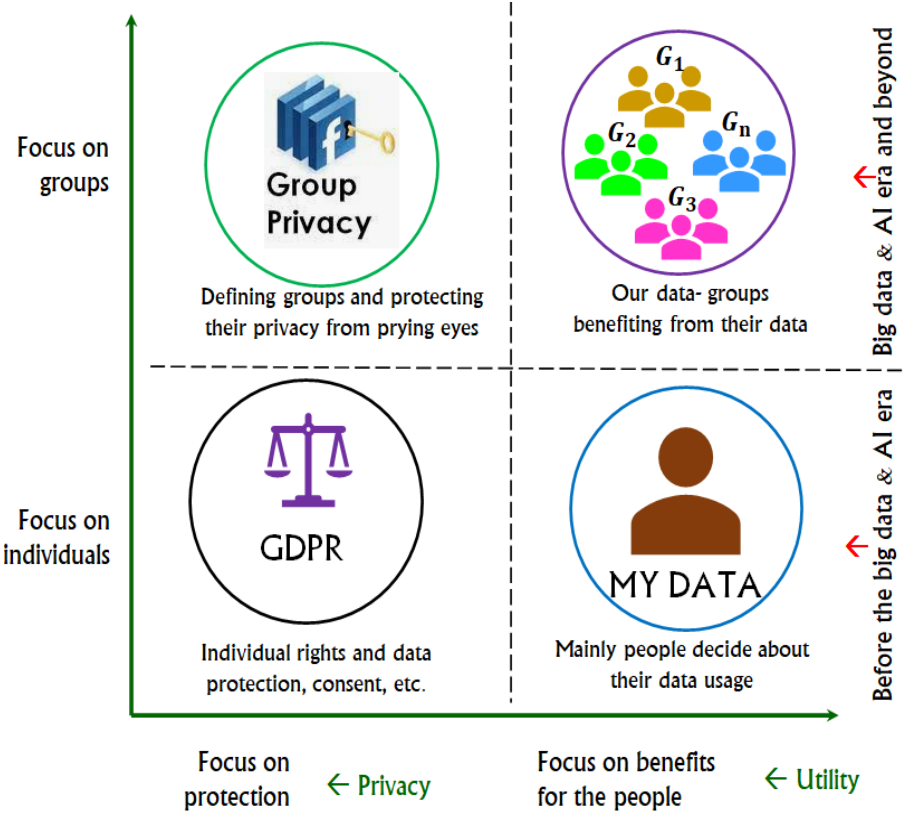
Figure 12. Overview of the changing dynamic of individual and group privacy (bright and dark